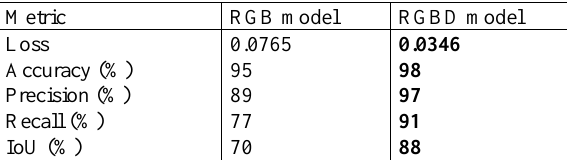
Table 3 . The results of footprint extraction on the test dataset.